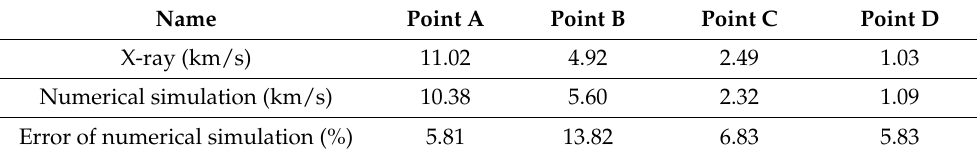
Figure 19. Jet image under pulsed X-ray: ( a ) 40 µ s; ( b ) 45 µ s; ( c ) 60 µ s, “A, B, C, D” is the reference position. Table 4. Comparison between jet velocity in numerical simulation and X-ray test